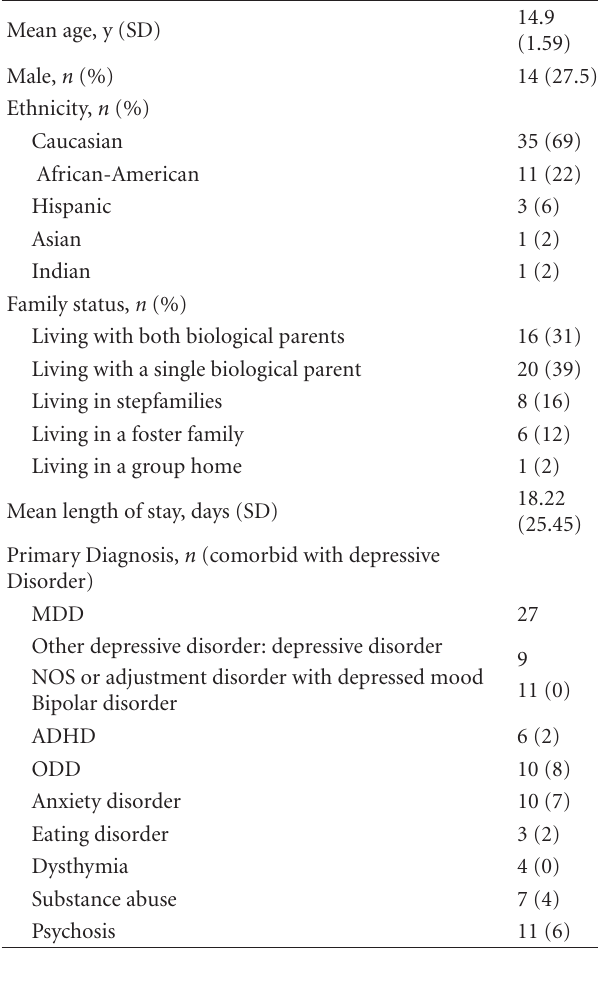
Table 1: Description of the sample ( N =